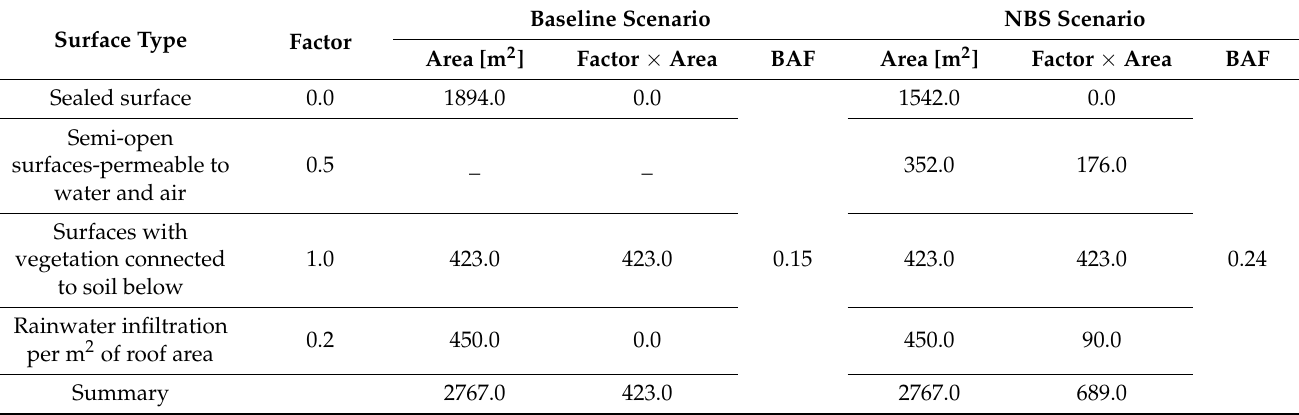
Table 5. The results of BAF analysis.